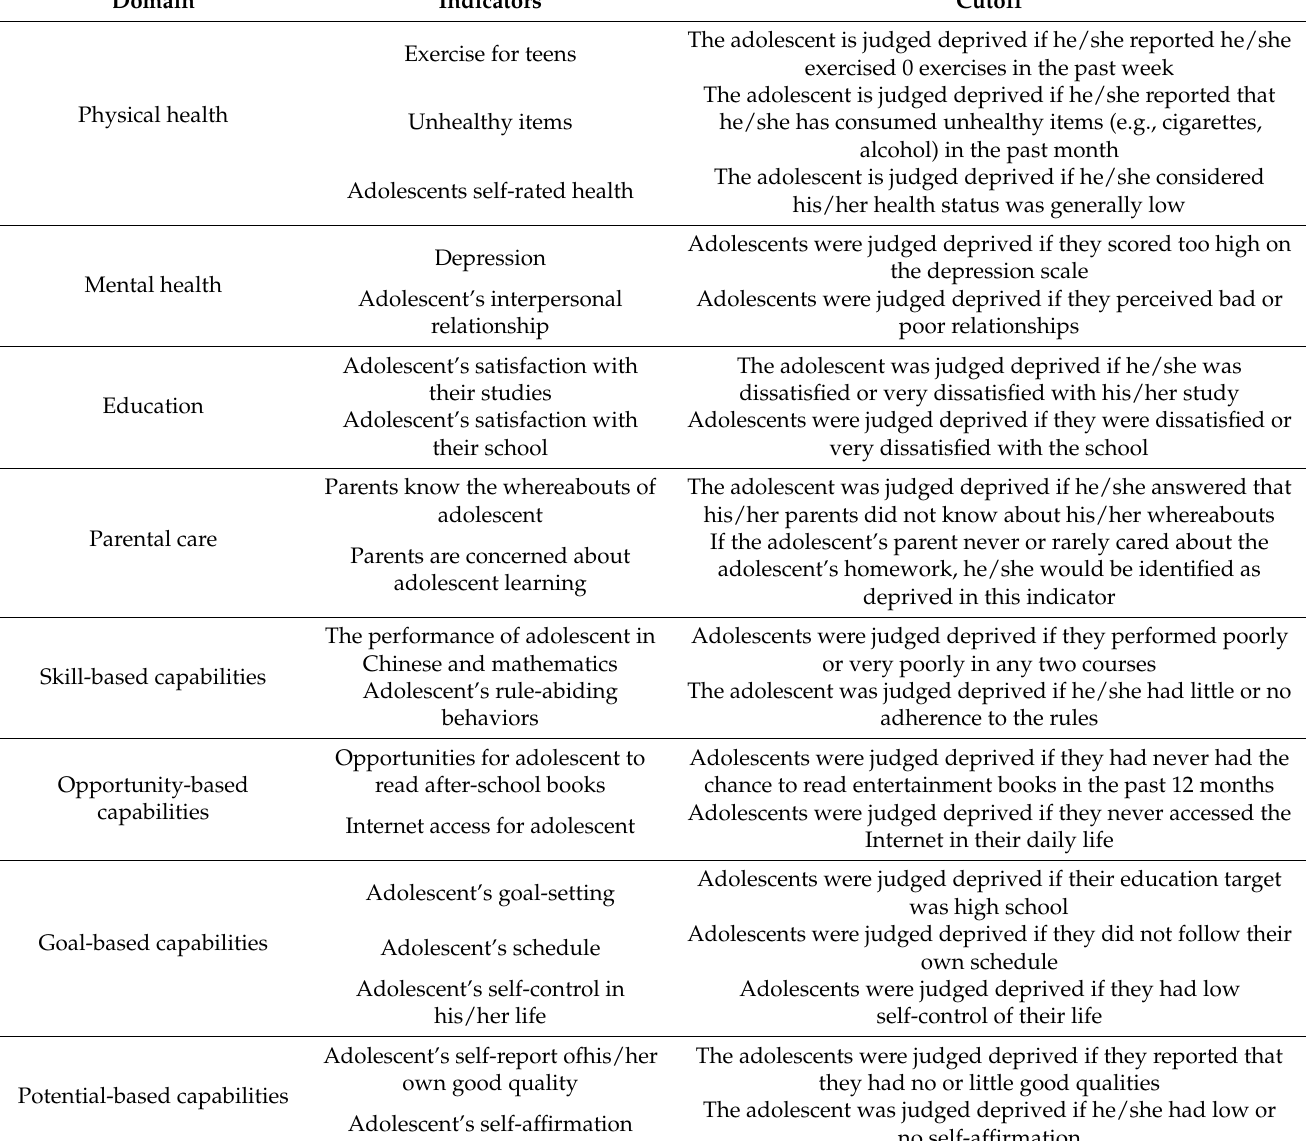
Table 1. Measuring dimensions, indicators, and cutoffs for functionings and